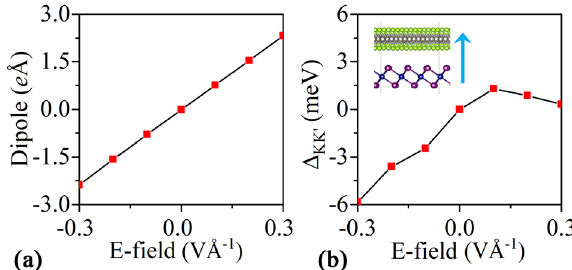
Fig. 6 Dipole moment and KK ′ valley splitting as functions of applied E- fi eld. a Dipole moment of the CrI 3 /WSe 2 heterostructure. b Valley splitting at KK ′ valleys. Inset in b shows the direction of the fi